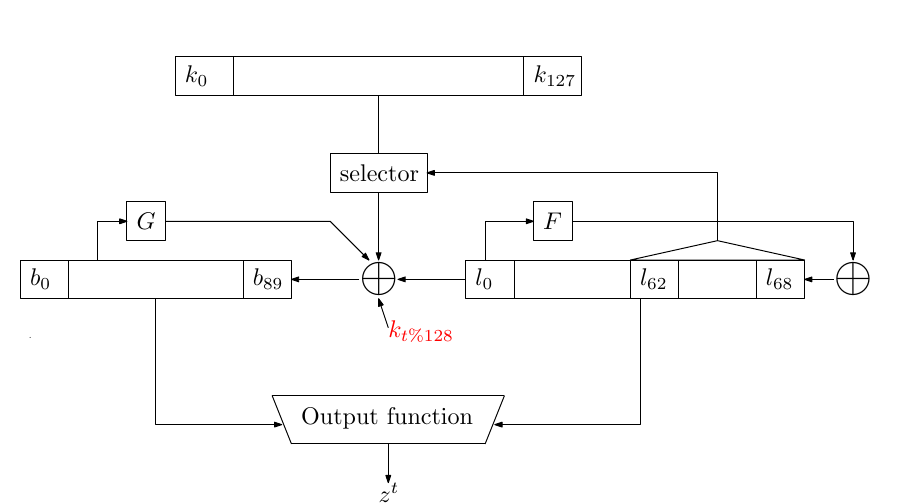
Figure 3: Illustration of the keystream generation